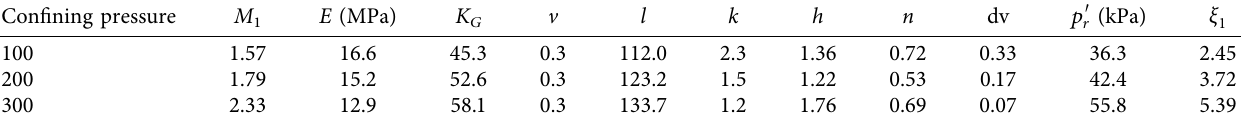
Table 3: The parameters for Shantou dredger